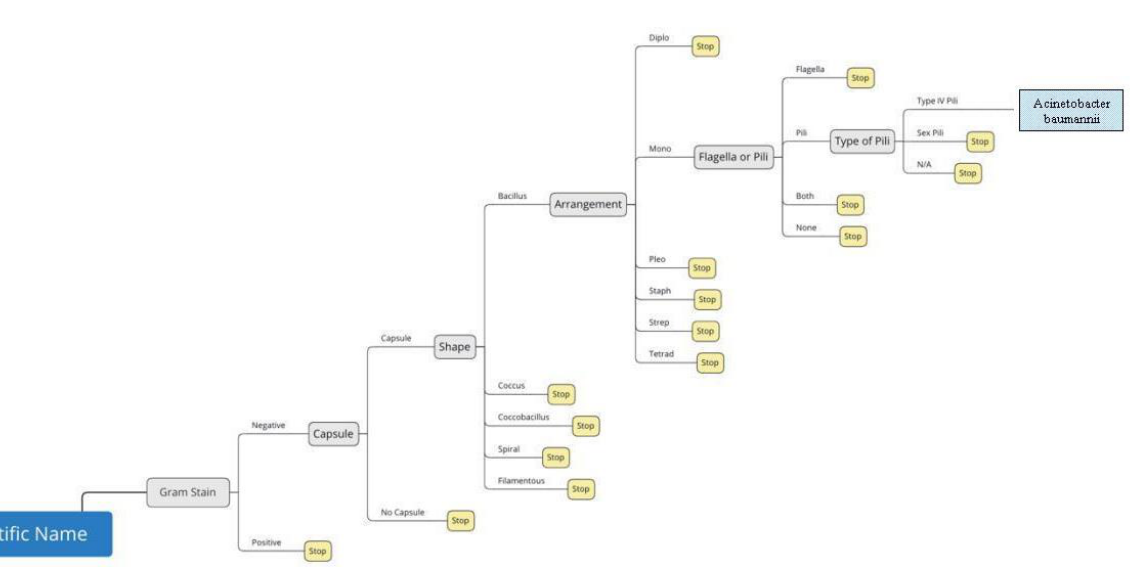
Figure 5. Visual representation of the decision tree for Acinetobacter baumannii . Blue box: Root node; Grey boxes: internal nodes; Yellow boxes: leaf nodes; Green box: result. Branches connect the nodes and are the drop-down menu options.